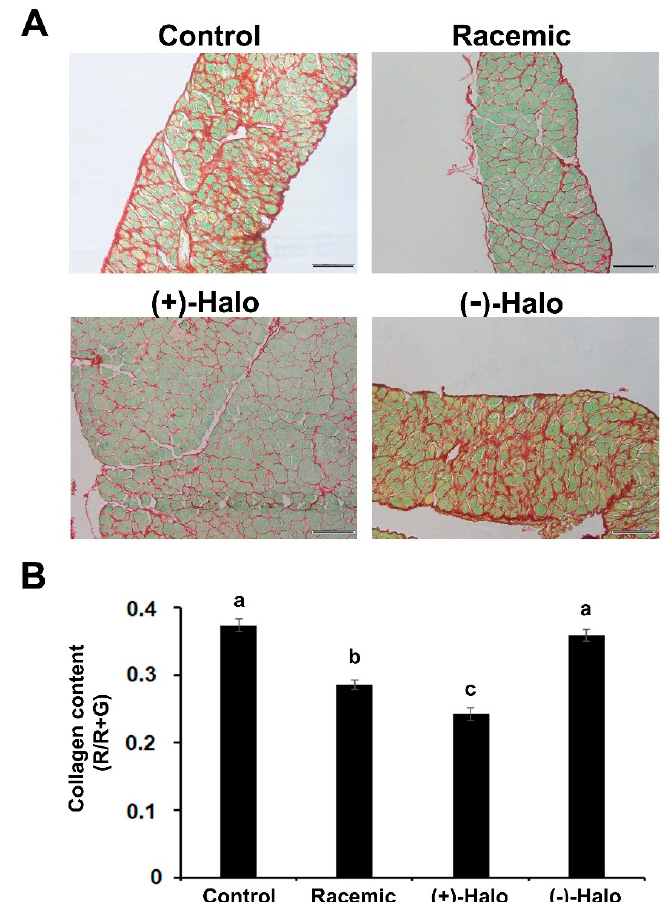
Figure 3. Collagen content in diaphragms of mdx mice at 14 weeks of age. ( A ) Sirius red staining of diaphragm sections derived from mice treated for 10 weeks with saline (Control), (+)-halofuginone enantiomer [(+)-Halo], (-)-halofuginone enantiomer [(-)-Halo] or their racemic combination (Racemic; 10 µ g/3 times per week). Note the high levels of red staining representing the fibrillar collagens (types I and III) in the Control and (-)-Halo groups against the large reduction in the Racemic and (+)-Halo groups. Bar, 100 µ m. ( B ) Quantitative analysis of collagen levels in the diaphragms. The proportion of the collagen content was calculated as red area (R) divided by the total area (red + green, R + G) in 20 pictures from each of 3 different mice ( n = 60) and presented as (mean arbitrary units ± SEM). Bars with different letters indicate significant difference between groups ( p <